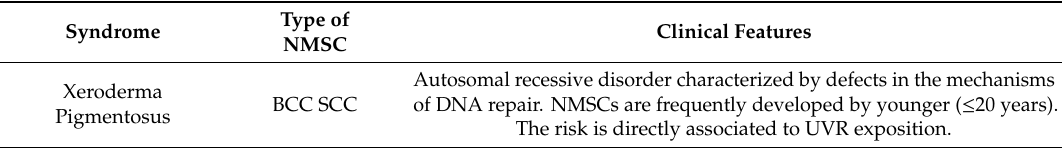
Table 1. Genetic syndromes associated with